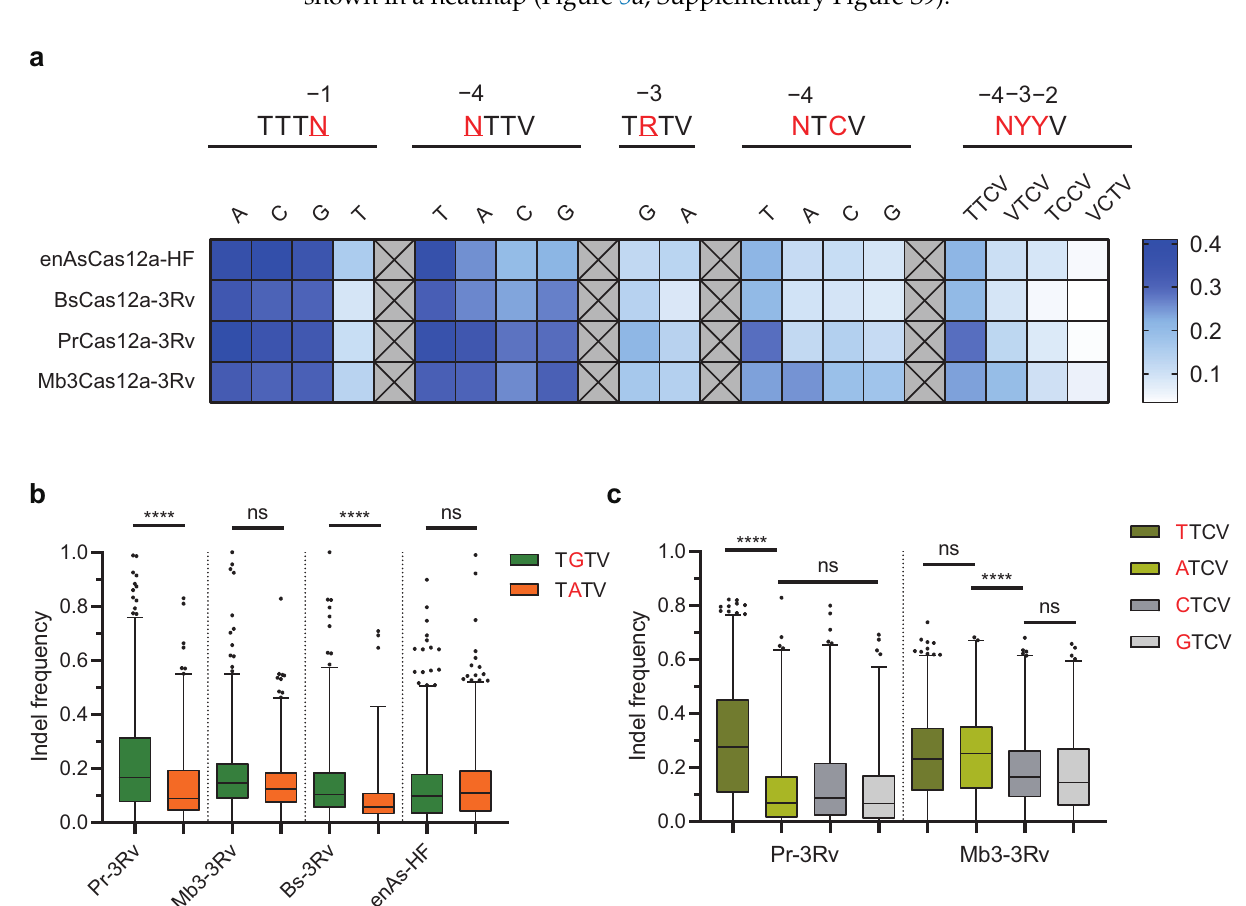
Figure 5. Characterization of base preferences in PAM recognition across four engineered Cas12a variants. ( a ) Base preference characterization in the 4-nt PAM sequences of four Cas12a variants (enAsCas12a-HF, BsCas12a-3Rv, PrCas12a- 3Rv, and Mb3Cas12a-3Rv). The values in the heatmap show a comparison of the average indel frequencies induced by the four Cas12a variants at target sites with different PAM sequences. The white-to-dark-blue gradient represents increasing editing efficiency. Degenerate bases are highlighted in red with a number marked on top to indicate its positions in the PAM tested for base preference. For exact values of the average editing efficiencies, see the Supplementary Note. ( b ) Comparison of tolerance for nucleotides G and A at position − 3 in PAM TRTV (R = A/G; V = A/C/G) among the four Cas12a variants. ( c ) Base preference at position − 4 in the PAM NTCV (N = A/C/G/T) of PrCas12a-3Rv and Mb3Cas12a. ( b , c ) Box-whisker plots: median line, quartiles for box edges, 1–99% whiskers. **** p < 0.0001; ns: not statistically significant. For details of sample size and of the statistical analyses, see the Supplementary